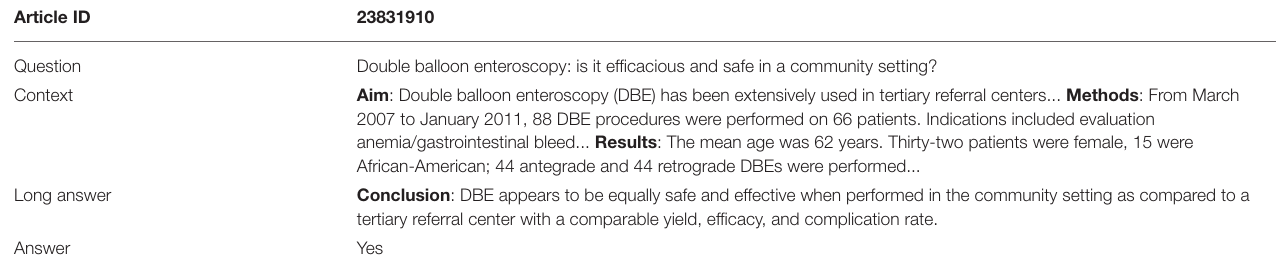
TABLE 2 | A sample with annotation in the PubMedQA